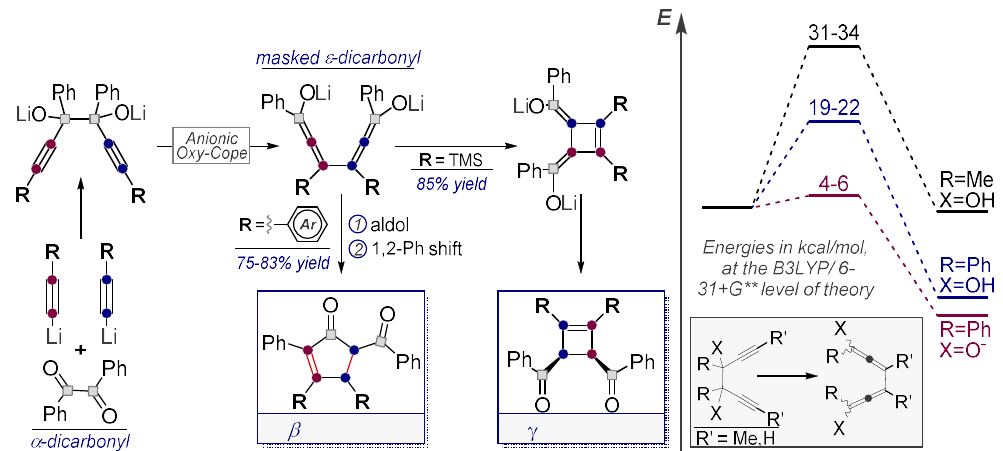
Scheme 47. Insertion of cyclobutene ring between two carbonyl carbons via pericyclic chemistry of